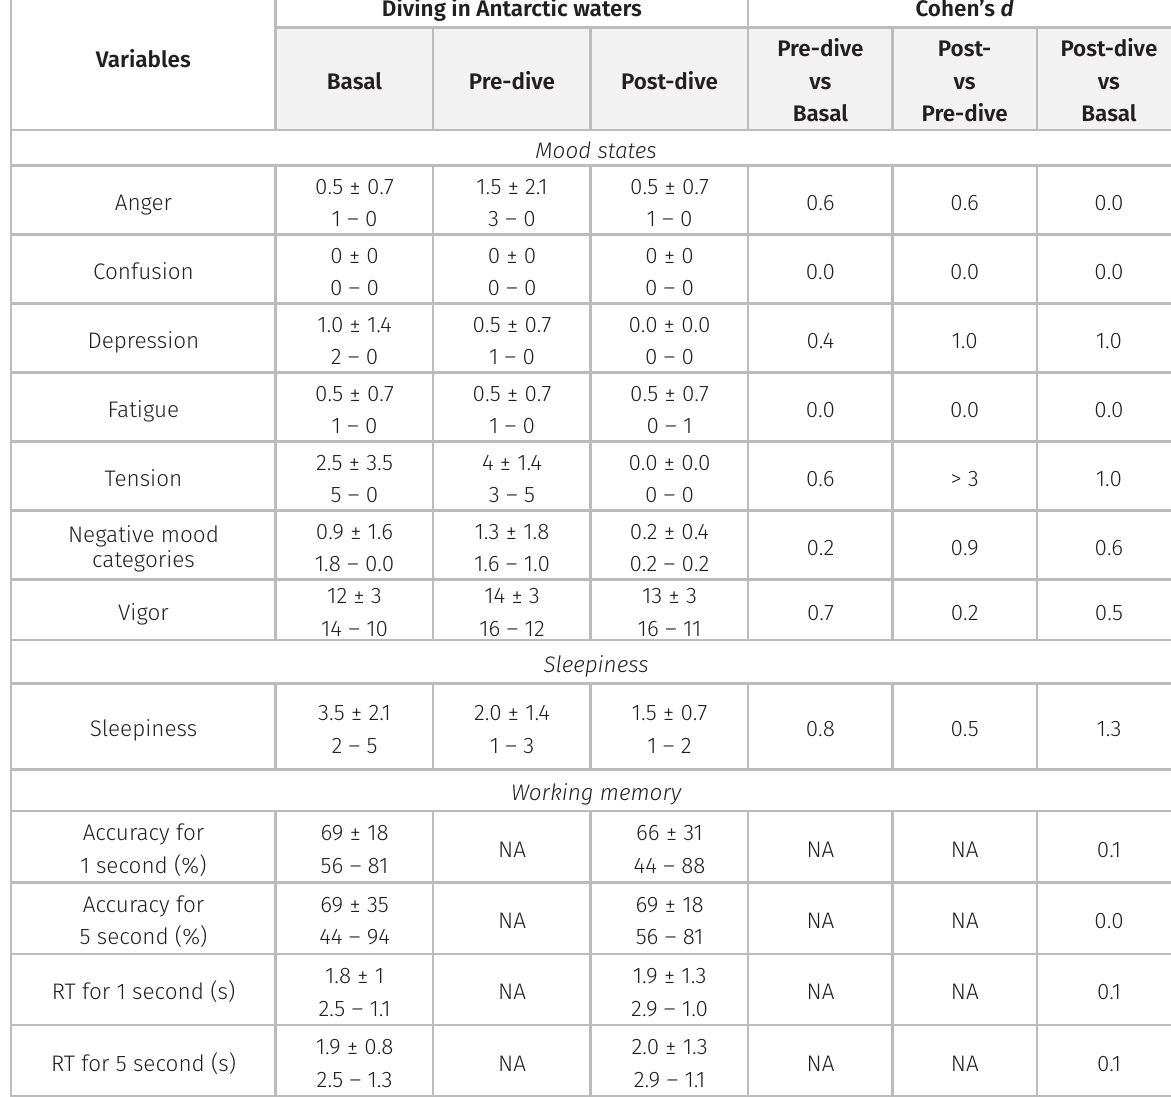
Table V. Mood, sleepiness, and working memory measured at three time points (baseline, pre-dive, and post-dive) in the Diving group